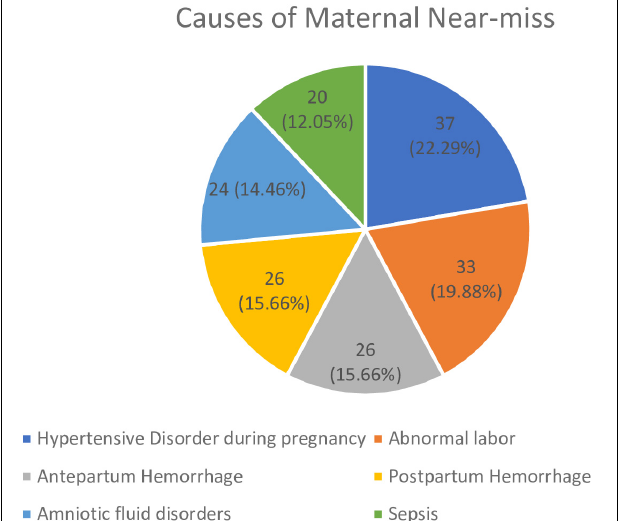
FIGURE 1 | Causes of maternal near-miss during pregnancy, childbirth, and postpartum period in West Shewa Public Health Institutions, Ethiopia, 2020 ( N =